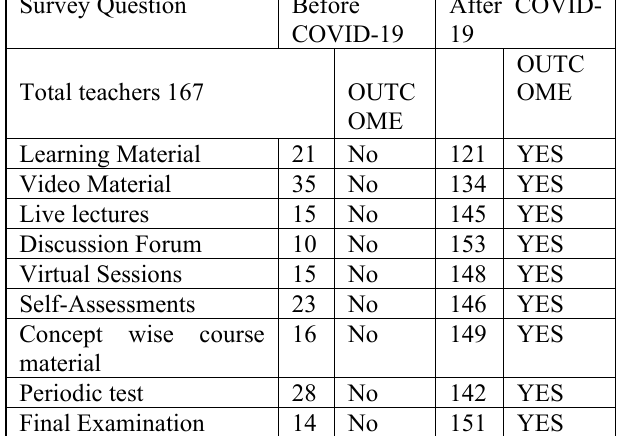
Table 2. Comparison of the performance of teacher between the before lockdown and after